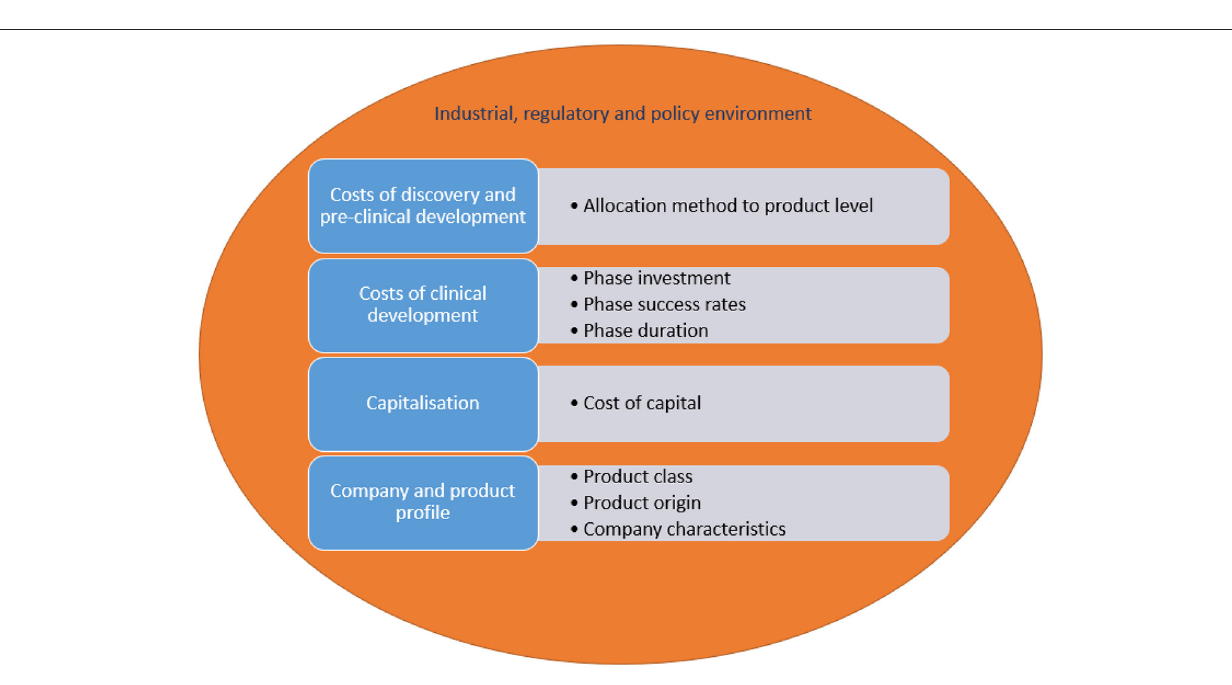
level data need to be allocated to individual medicines.